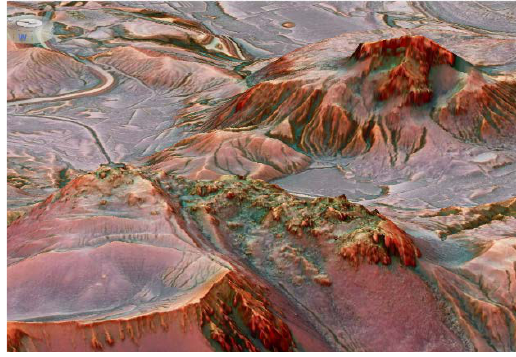
Figure 4. DEM and RRIM